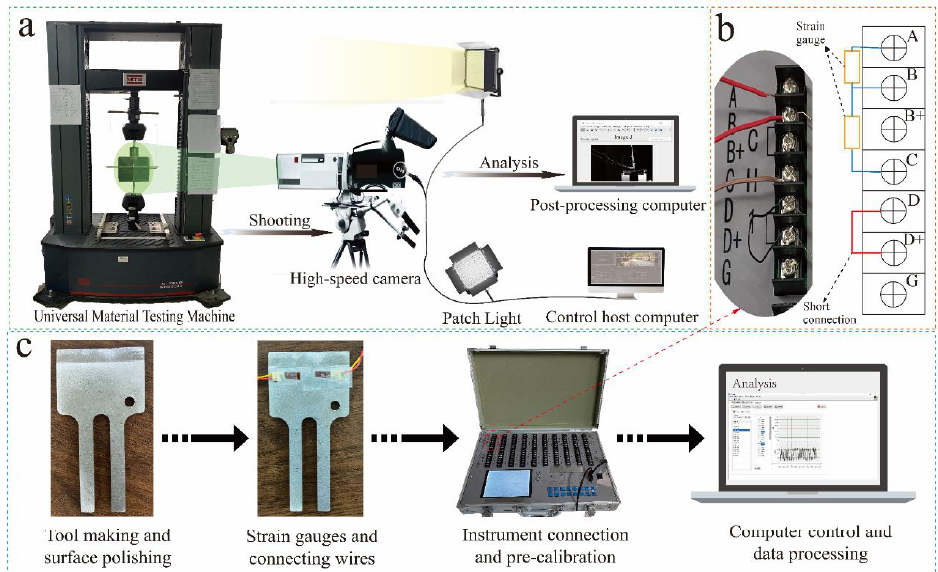
Figure 9. Schematic diagram of the induction comparison experiment. ( a ) Cutting tests are performed on one side, while the cutting process is filmed with a high-speed camera, and the computer controls the equipment and post-processes the data. ( b ) A half-bridge connection is used for the stress–strain tester, with a strain gauge in the middle of A-B, B-C, and a short circuit to D. ( c ) Induction contrast stress–strain test processing flow.